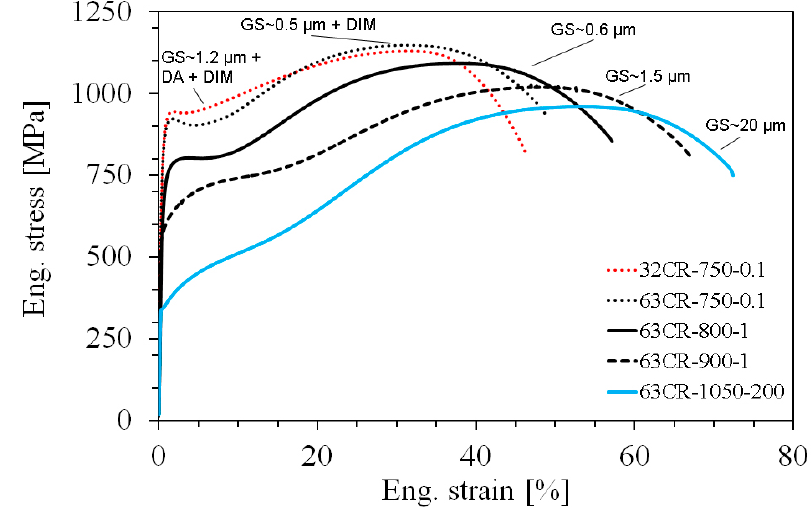
Figure 8. Examples of engineering tensile stress–strain curves for a 301LN ASS with refined grain size after various reversion treatments. Data collected from References [87,102,103]. Legend: Reduction (%CR), temperature (°C), duration (s).